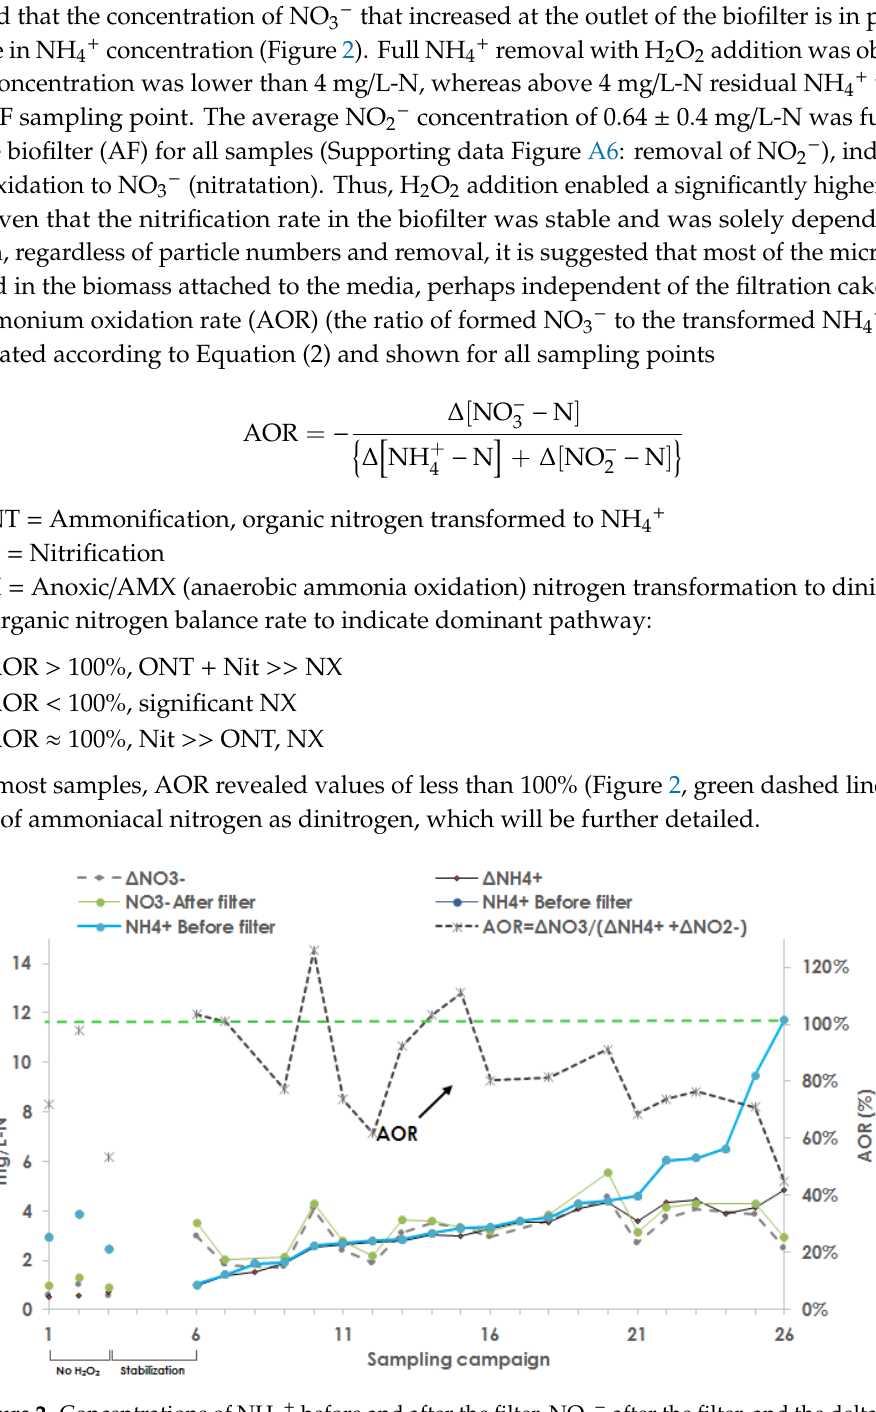
Figure 2. Concentrations of NH 4 + before and after the filter, NO 3 − after the filter, and the delta of NH 4 + and NO 3 − (mg / L-N) are presented. The gray dashed line represents the NH 4 + oxidation rate, which is the ratio between the introduced NO 3 − and the sum of the removed NH 4 + and NO 2 − (%). The green dashed line represents the complete (100%) calculated mass balance between removed NH 4 + and NO 2 − and introduced NO 3 − . The sampling campaigns were sorted by feed values of NH 4 + . The first three values represent the control without H 2 O 2 addition.